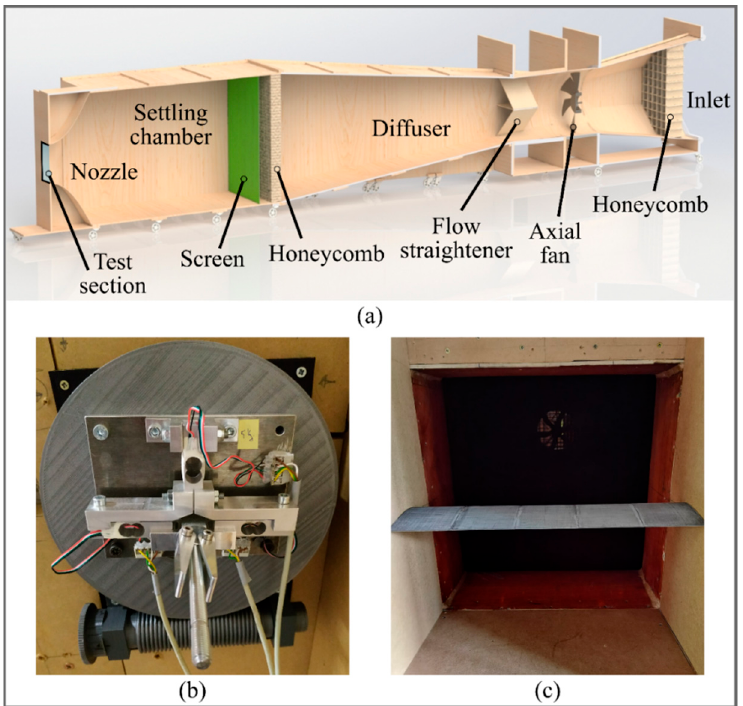
Figure 1. ( a ) Sketch of the wind tunnel (Courtesy of Angie L. Ramírez Celis). ( b ) Aerodynamic balance mounted on the mechanical orientation system. ( c ) DU06-W-200 airfoil prototype in the test section.